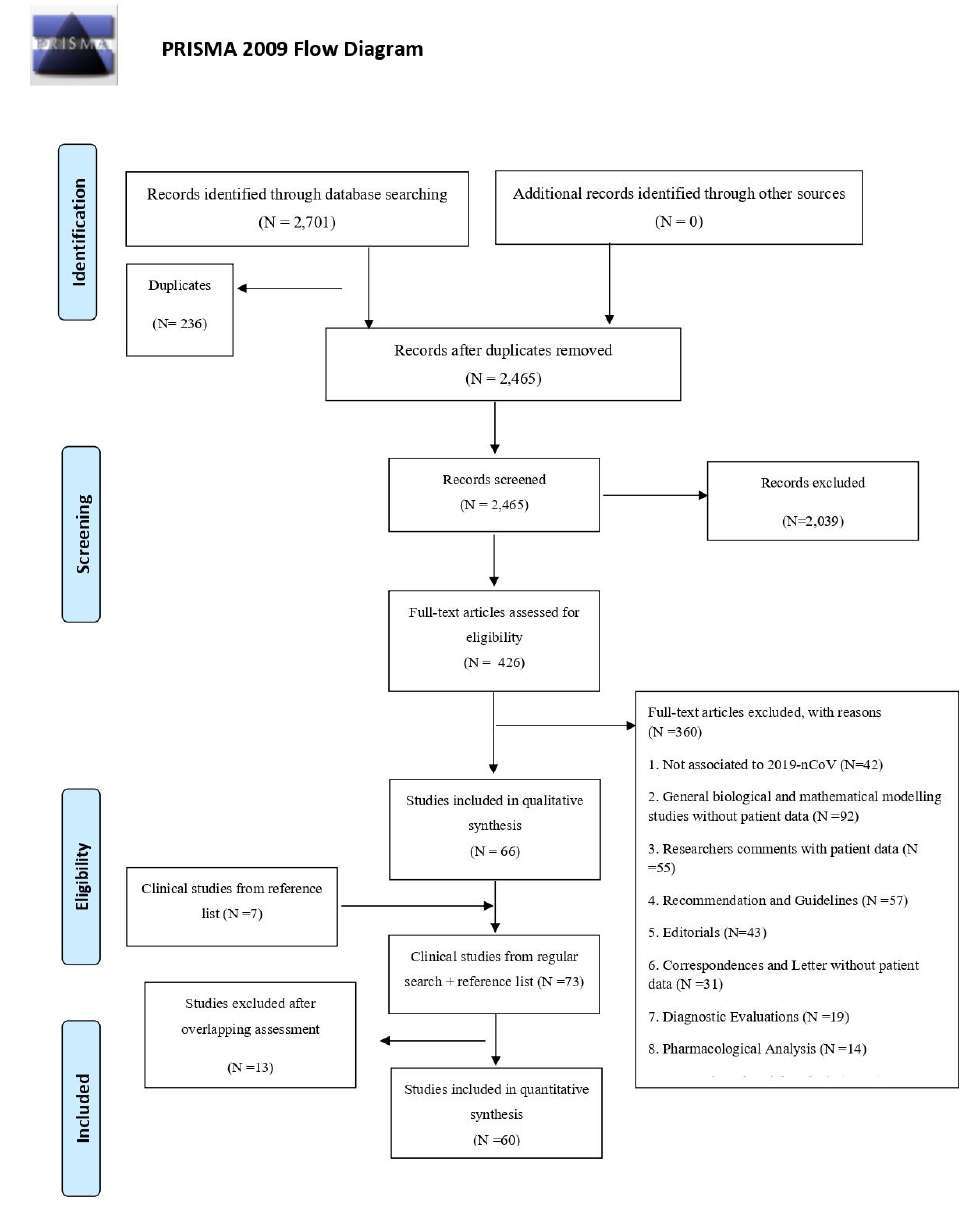
Figure 1. Prisma flow